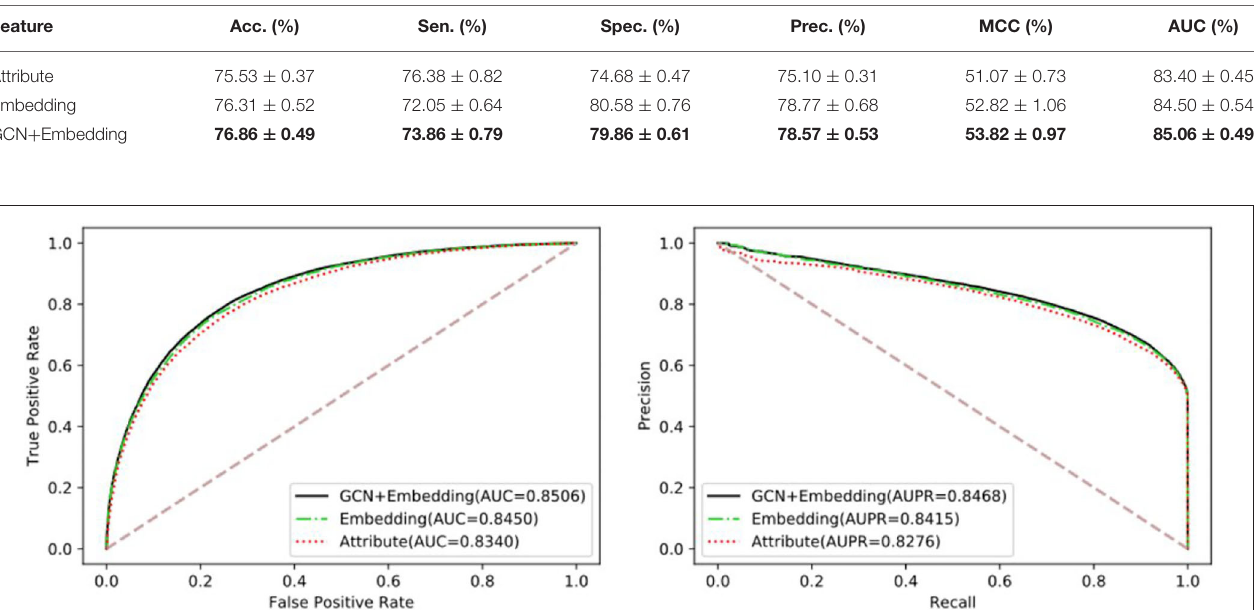
FIGURE 3 | The comparison of different feature using Gradient Boosting Decision Tree classifier.